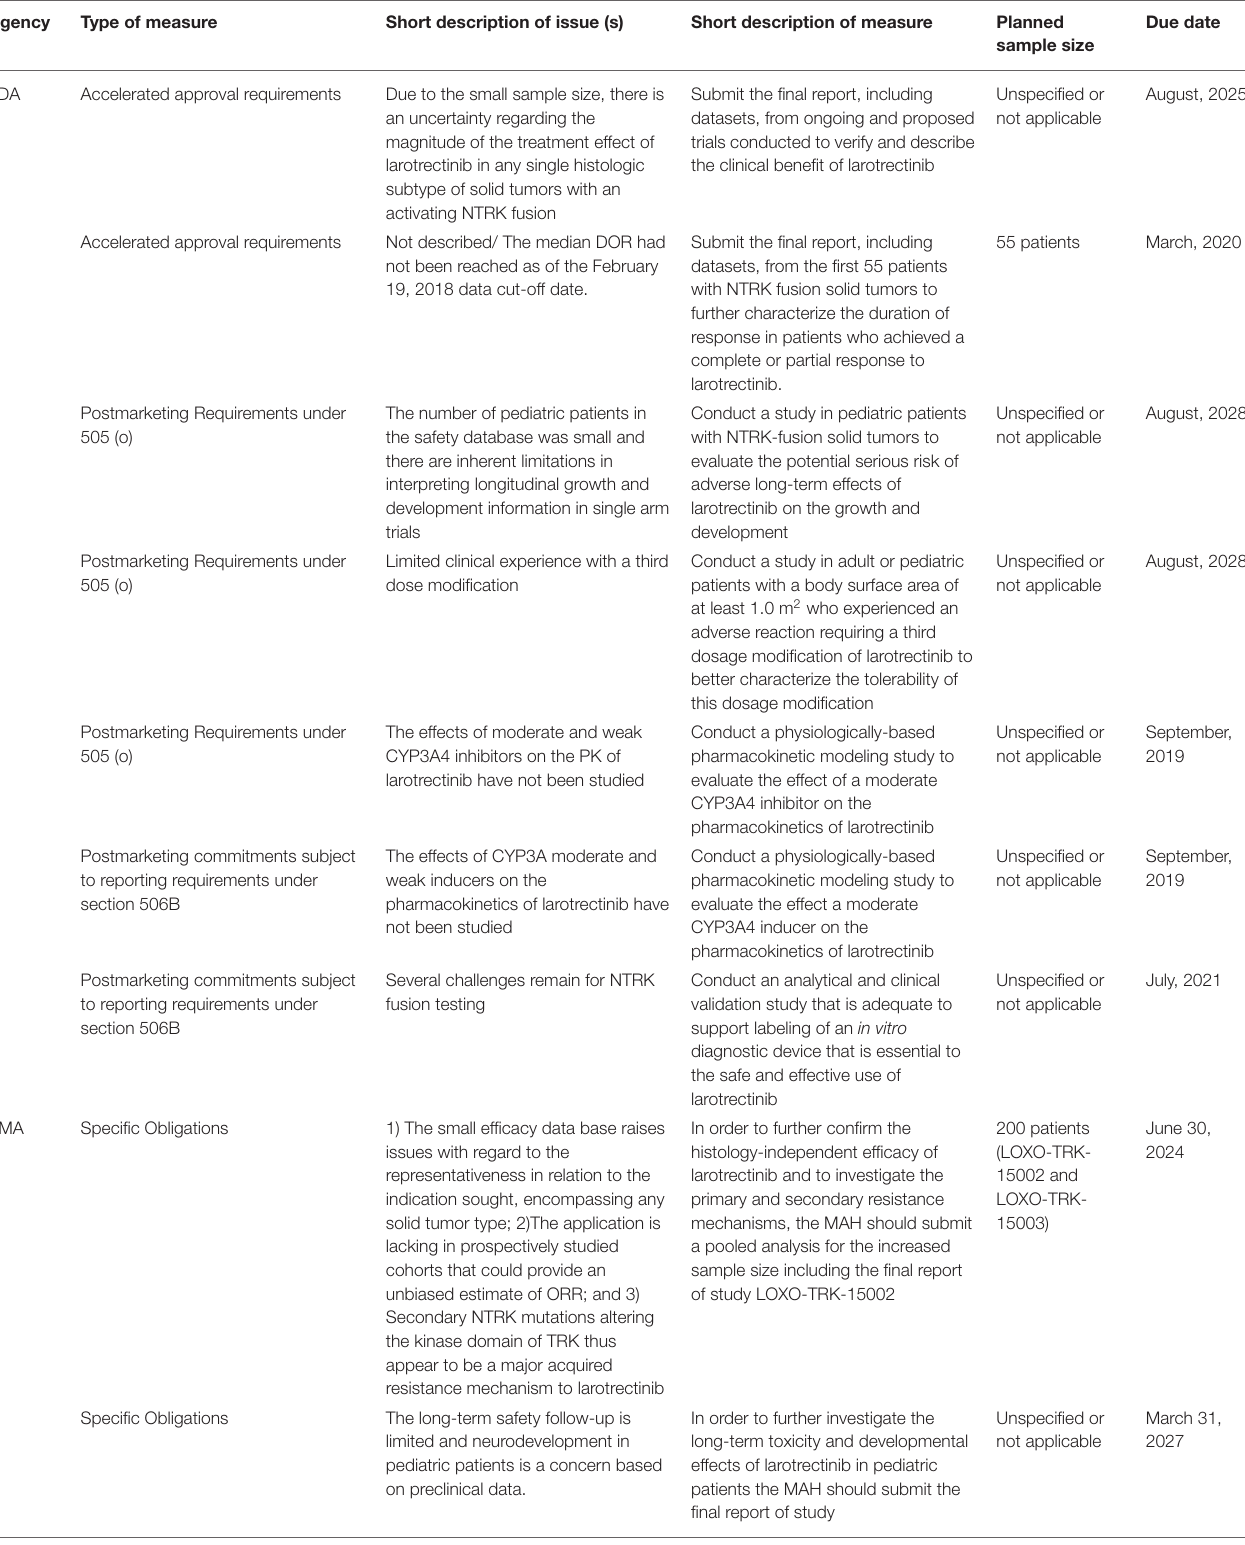
TABLE 5 | Post-marketing measures for larotrectinib for the treatment of NTRK tumors.